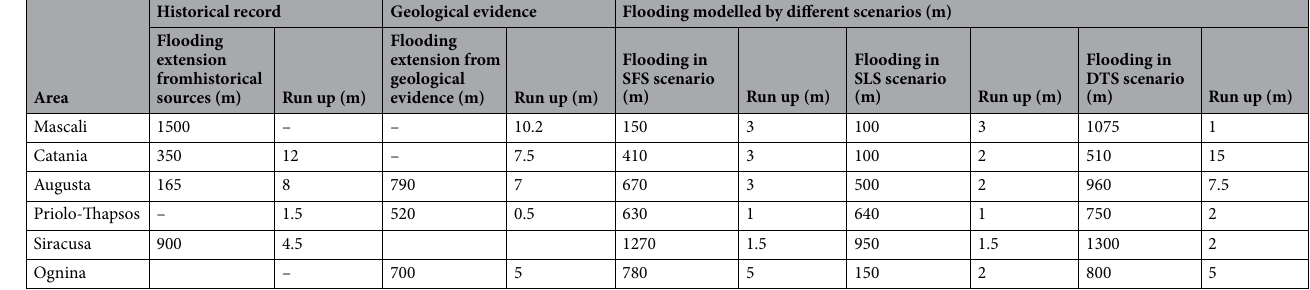
first with a height of about 12 m and the second with a height of about 9 m (Fig. 6c). Both waves in the DTS sce- nario showed an increase in wave height of about 13 m, with a double withdrawal in the proximity of the coasts. The numerical modelling in Celeris environment showed a different extent of flooding following the afore- mentioned scenarios (Table 3), highlighting how the DTS determined greater extent of flooding than others. The sensitivity of the inundation for each scenario depends on the amplitude of the incoming wave and the topography of the coastal region. Gibbons et al. 71 demonstrated that the sensitivity of the inundation area to the Manning value is likely to be greater when the topography increases slightly. However, for the low-lying areas, the sensitivity of inundation is less dependent to the Manning value 71,87 where the coastal slope is the main driven factor of inland flooding. This appears to be in agreement with what was estimated by Scicchitano et al. 73 along the coasts of south-eastern Sicily through the use of Terrestrial Laser Scanner technique. According to Tonini et al. 30 and Argnani et al. 28 , a tsunami due only to submarine slide may not have deter- mined a flooding surface as reported in historical records. However, the geophysical surveys showed the pres- ence of a submarine landslide of significant volume that, as also suggested by Paparo et al. 29 , can generate a high tsunami wave in deep water. Therefore, the dual mechanism of fault displacement and submarine landslide could represent a step-forward in resolving the source of tsunami of 1693 AD. The Boussinesq model was compared with the non-dispersive model based on the nonlinear shallow water equations (NLSWE) applied for DTS scenario. The Boussinesq model includes the lowest order effects of frequency dispersion and nonlinearity, which can reproduce the soliton fission effects (consisting in the split of waves from tsunami crest) and the intensification of tsunami height. Furthermore, this behaviour was also observed in the airborne video footage taken at the northern Sendai Bay during the Tohoku earthquake tsunami 88 . On the other hand, NLSWE is not able to describe the frequency-dispersion behaviour for tsunami propagation (Fig. 10). Simulations with different time delays between fault displacement and landslide movements were performed to choose the more reliable scenario for the tsunami of 1693 AD. Modelling performed with 0 min and 1 min of delay showed a destructive interference of the waves, without the genesis of two consecutive waves impacting the coast (Fig. 11). Modelling performed with 2 min, 5 min, 10 min are more reliable for the simulation of the 1693 tsunami event, as they show two distinct waves divided by the negative sea-surface elevation due to mass deficit during the landslide movement. The delay of 2 min between earthquake and submarine landslide was chosen to reproduce the worst-case scenario, in which the combined wave fronts due to fault and landslide provide the greatest flooding surfaces. Since modelling with a simultaneous displacement of fault and landslide resulted in a destructive wave interference, due to the velocity of the landslide less than the seafloor deformation (Fig. 11), it is necessary to take into account the relatively slow motion of landslides and its delay with respect to the wave generated by fault displacement. Another important evidence supporting the DTS scenario is the double withdrawal reported in historical documents along several coastal areas. The multi-withdrawals observed during tsunami events are usually con- nected to three main processes: (i) the different slip distribution during an earthquake 89,90 , (ii) the reflectivity of the coastal morphology impacted by tsunami wave fronts 91 , (iii) the different triggers of waves during the tsunami event (different fault displacements, coastal landslides, submarine landslides, etc.) 30,66 . The spatial and temporal difference on the slip distribution was the trigger of tsunamis of Tohoku, 2011 AD 92,93 , where multi- withdrawals were observed in function of the different waves caused by distinct slips of sub-faults of Japan Trench. On the other hand, the coastal morphology can determine the tsunami reflection, as happened in Vathy Bay, NE Samos, 2020 AD 94 , and in the Sendai Plain, Japan, 2016 AD 91 . The multi-withdrawals are mainly attributed to multi-sources causing tsunamis, and many examples were reported for Sulawesi, Indonesia, 2018 AD 95 , where fault displacement and coastal landslides determined distinct tsunamis in the Palu Bay. In our study case, double